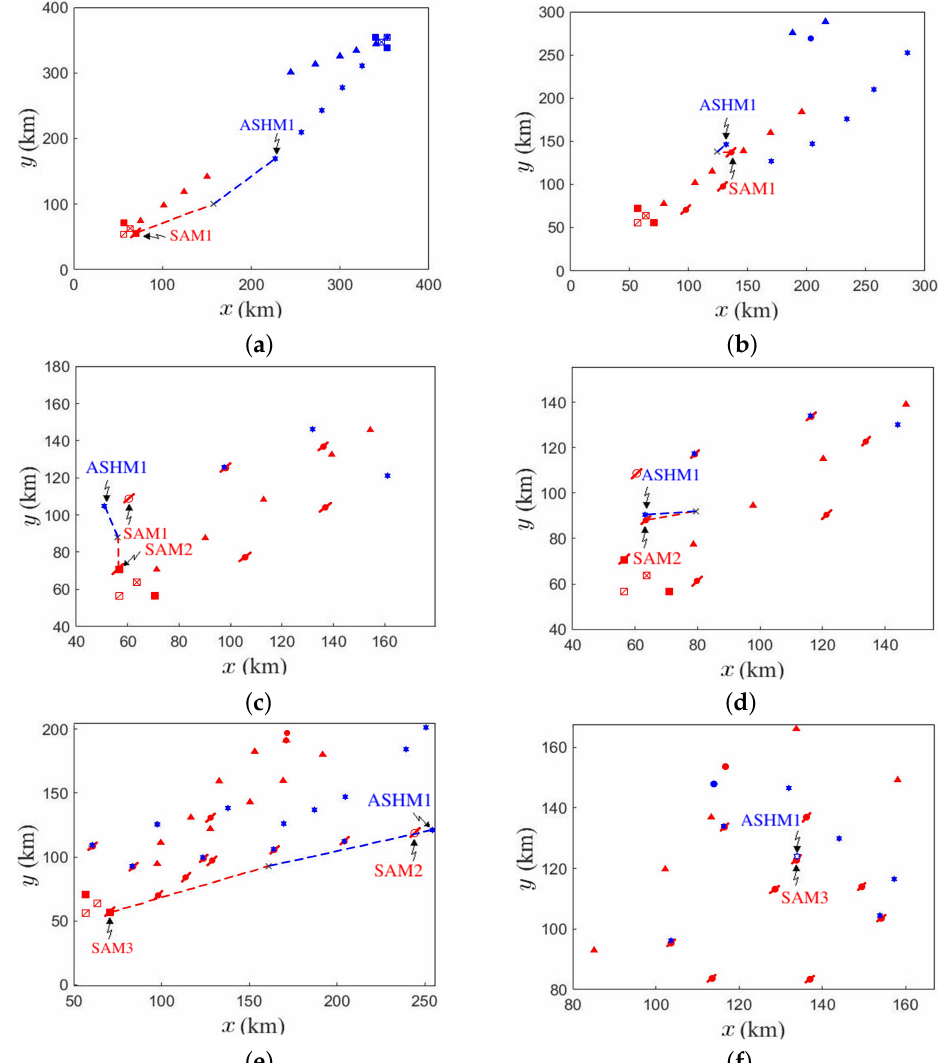
Figure 22. Specific game on A1/B2, an ASHM from CG-B evading SAMs from fleet A, ( a ) t = 390 s, ( b ) t = 570 s, ( c ) t = 705 s, ( d ) t = 735 s, ( e ) t = 1020 s, ( f ) t = 1260 s. Symbols are referred to Table